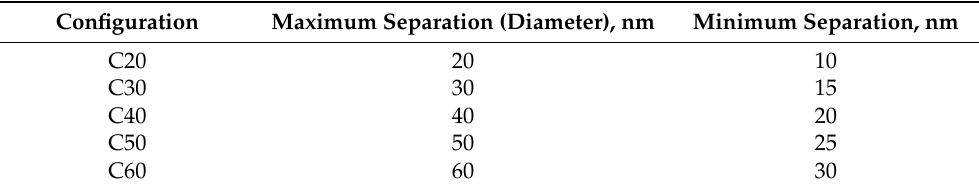
Table 1. Handle separation for cholesterol attachment in the circular configuration. The maximum separation is across the diameter of the circular configuration while the minimum separation is between adjacent cholesterols.